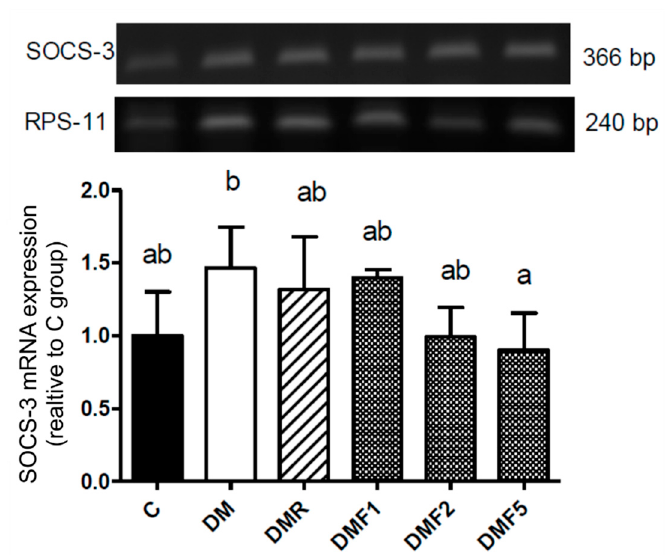
Figure 6. Effects of fucoxanthin on SOCS-3 mRNA expression in rat hypothalamus after treatment for four weeks. Data are showed as the mean ± S.D. ( n = 5). The values with different letters (a–c) represent significant differences ( p < 0.05) as analyzed by Duncan’s multiple range test. C, control; DM, diabetes; DMF, diabetes treated with fucoxanthin; DMR, diabetes treated with rosiglitazone; SOCS-3, suppressors of cytokine signaling-3.